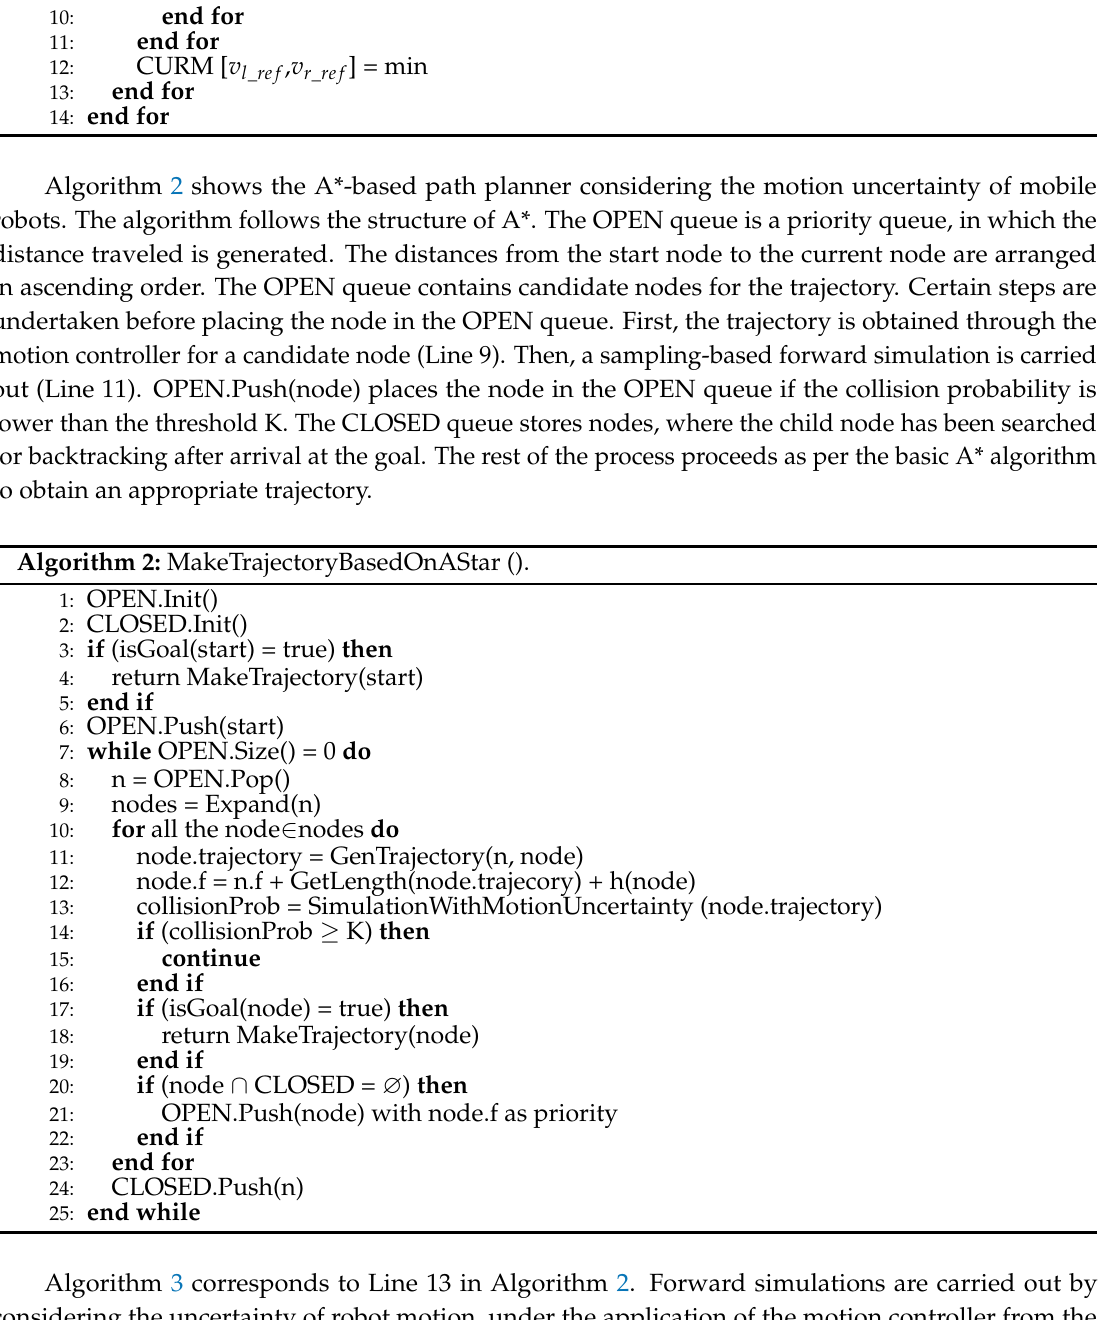
Algorithm 3 corresponds to Line 13 in Algorithm 2. Forward simulations are carried out by considering the uncertainty of robot motion, under the application of the motion controller from the parent node to the candidate child